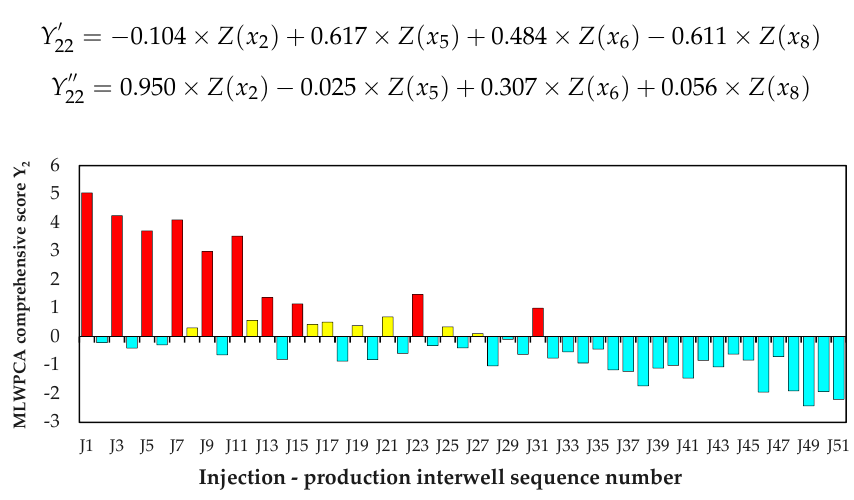
Figure 5. MLWPCA comprehensive score.